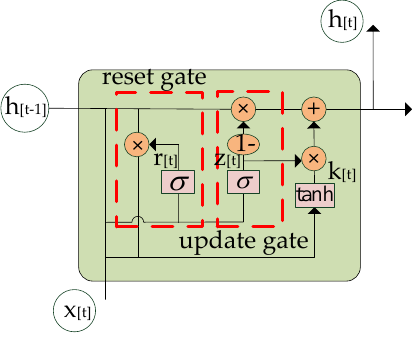
Figure 5. GRU structure diagram.